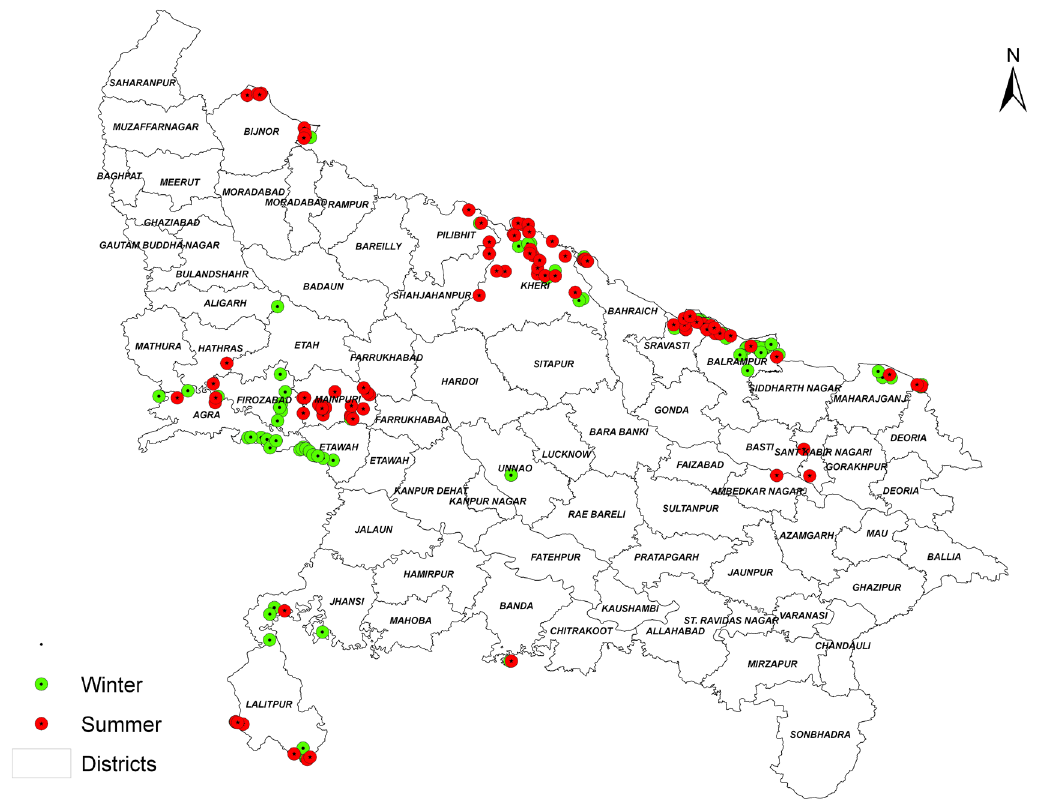
Figure 5. GPS data based location of vulture nesting sites in UP observed during summer and winter of